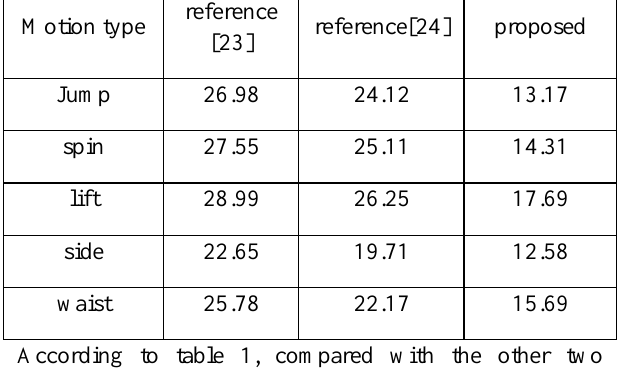
Table 2. Human limb image error in different